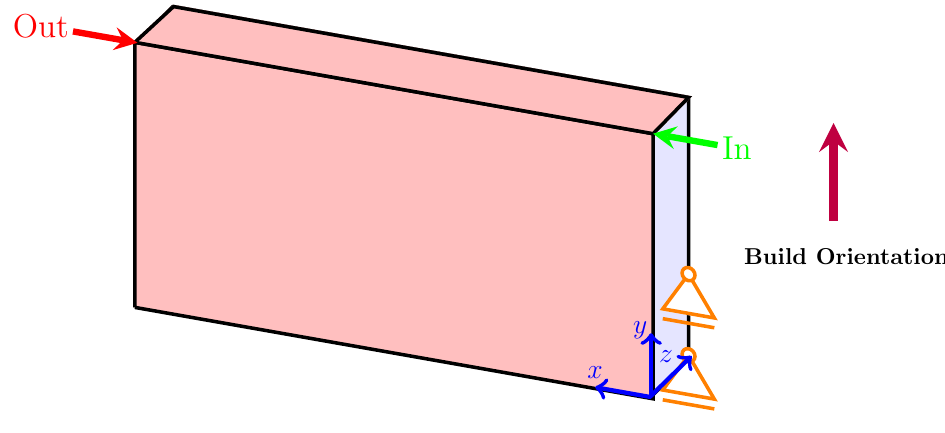
Figure 9. Design domain of force inverter design.